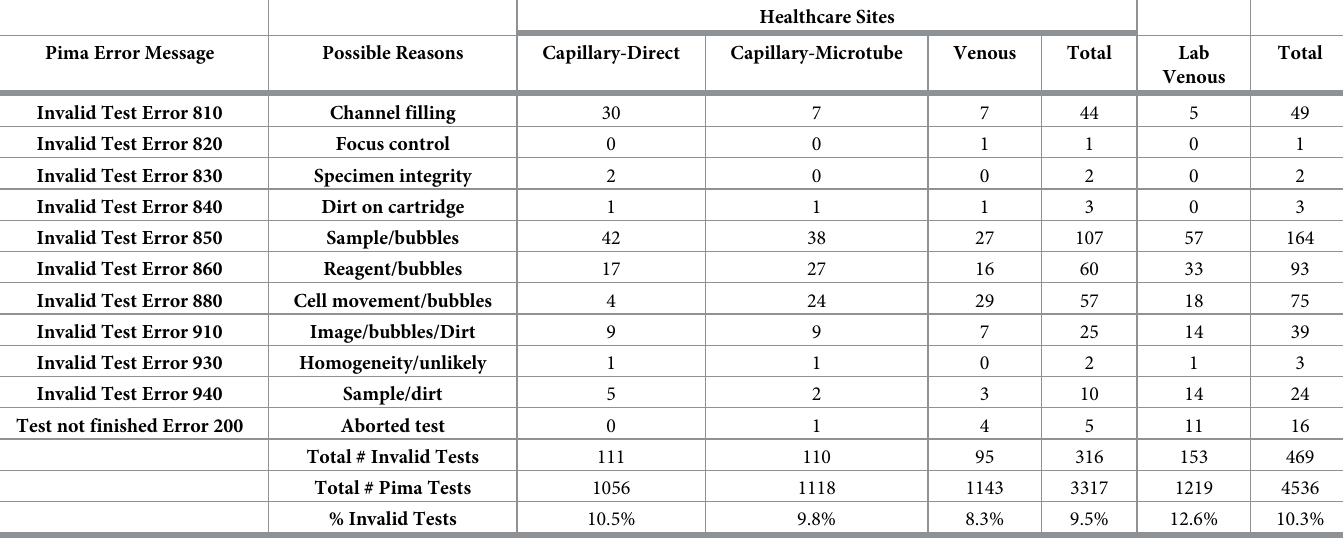
Table 2. Invalid Pima CD4 tests per testing site and specimen